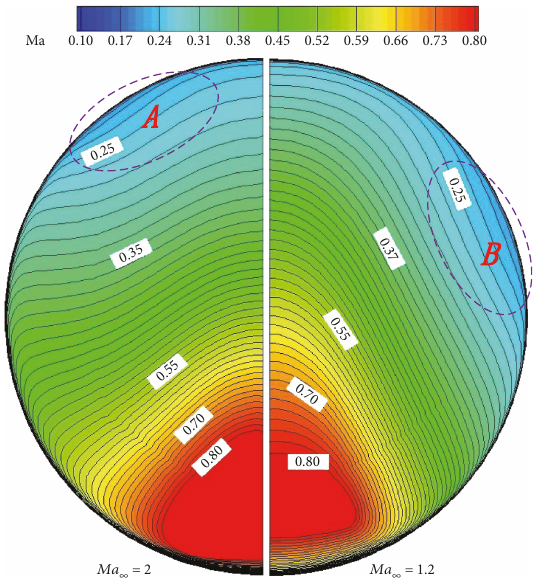
Figure 12: The exit Mach number distribution of the turbojet fl ow path at both Ma ∞ = 2 and 1.2.